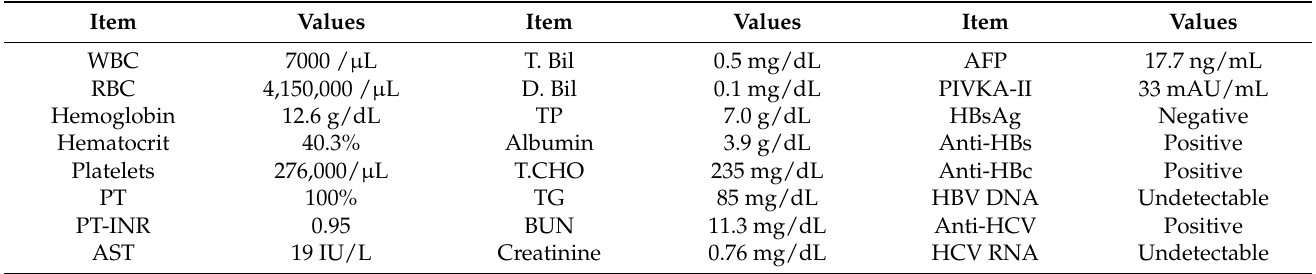
Table 2. Laboratory data of recipient about 8.5 years after living-donor liver transplantation